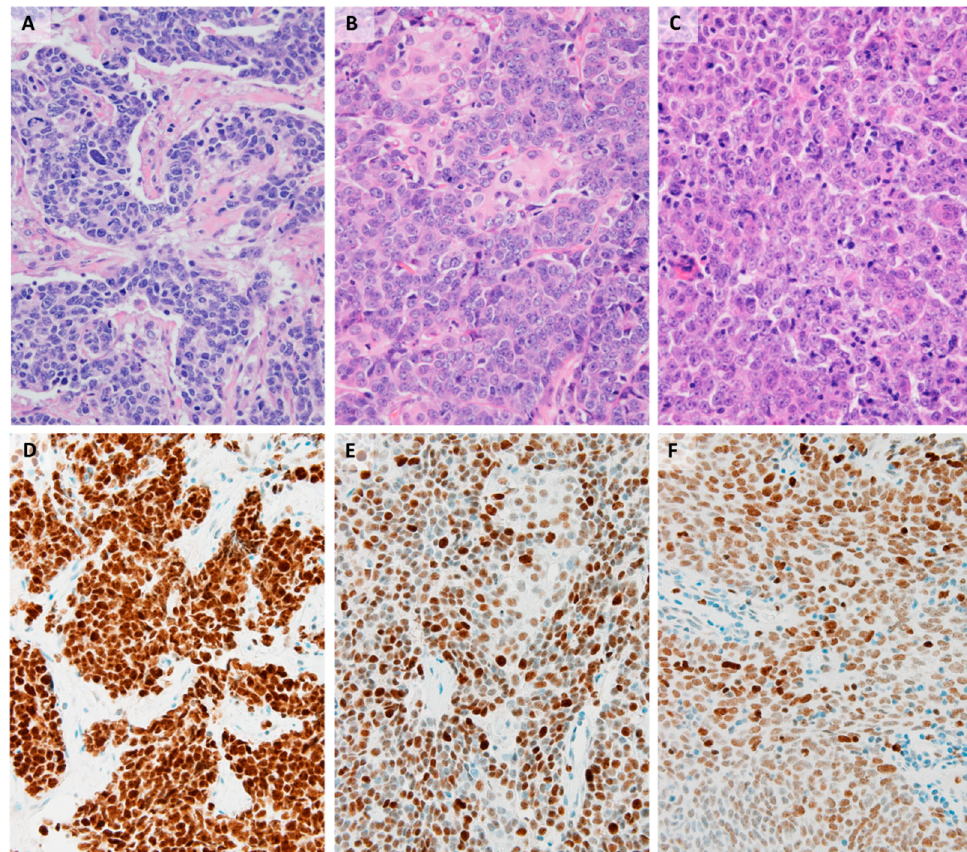
Figure 2. Hematoxylin and eosin ( A – C ) and EZH2 ( D – F ) immunostaining in thymic carcinomas ( A , D : small cell carcinoma; B , E : squamous cell carcinoma) and a type B3 thymoma ( C , F ). All images are at 400× magni fi cation and were scored as staining in ≥ 80% of tumor cells. Table 2. Proportion of cases with positive staining for EZH2 and POU2F3.